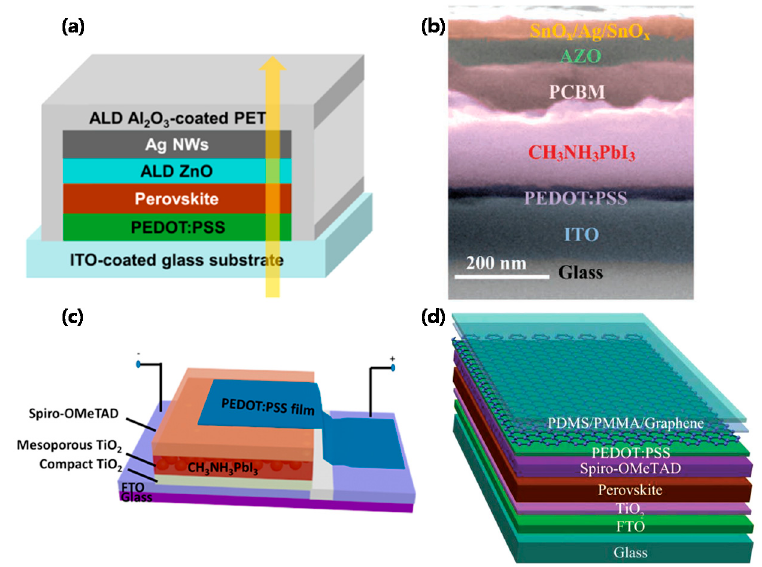
Figure 10. ( a ) Schematic illustration of a Ag NWs-TCE-based STPSC device architecture. Reprinted